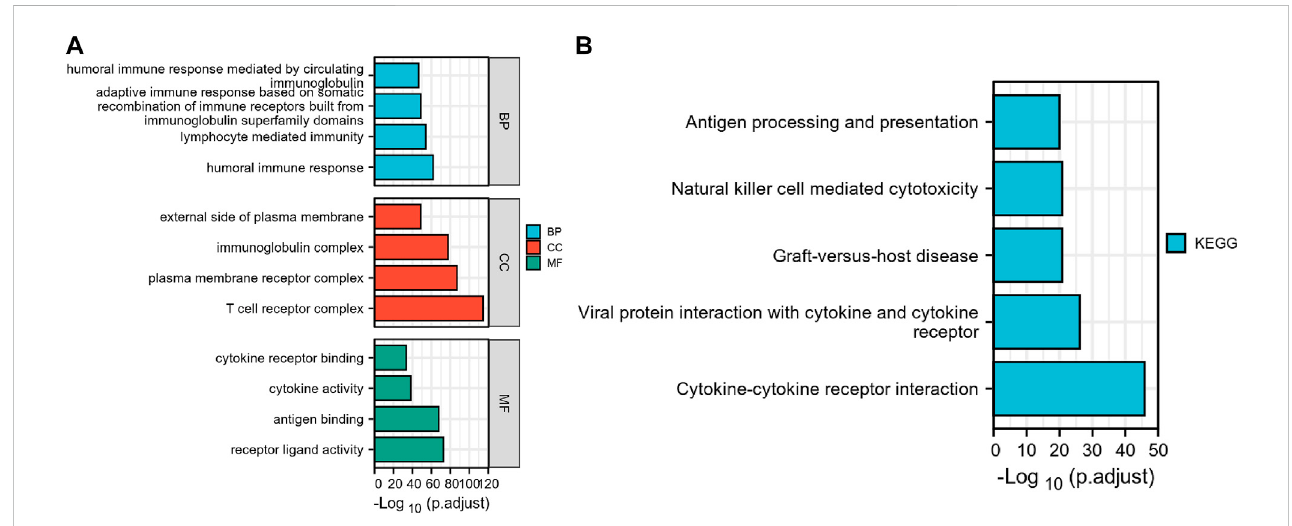
FIGURE 3 Differential genes expressed in normal and KIRC tissues are involved in immune-related pathways. (A) GO, Gene Ontology; (B) KEGG, Kyoto Encyclopedia of Genes and